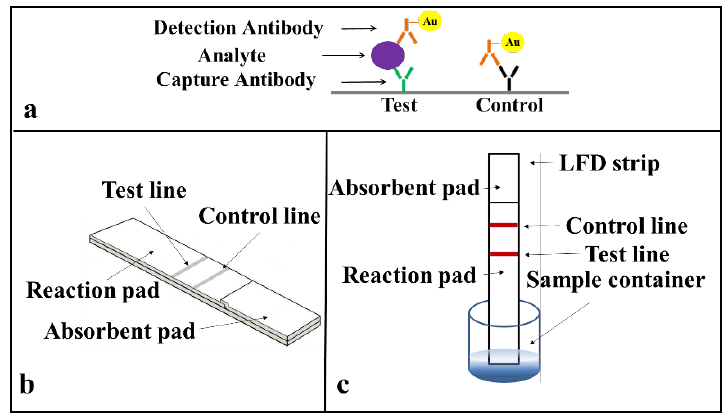
Figure 3. Schematic of ( a ) the sandwich enzyme linked immunosorbent assays (ELISA) protocol, ( b ) the simplified LFD we used for detection of C-reactive protein (CRP) and Serum amyloid A-1 (SAA1), and ( c ) detection operation method.